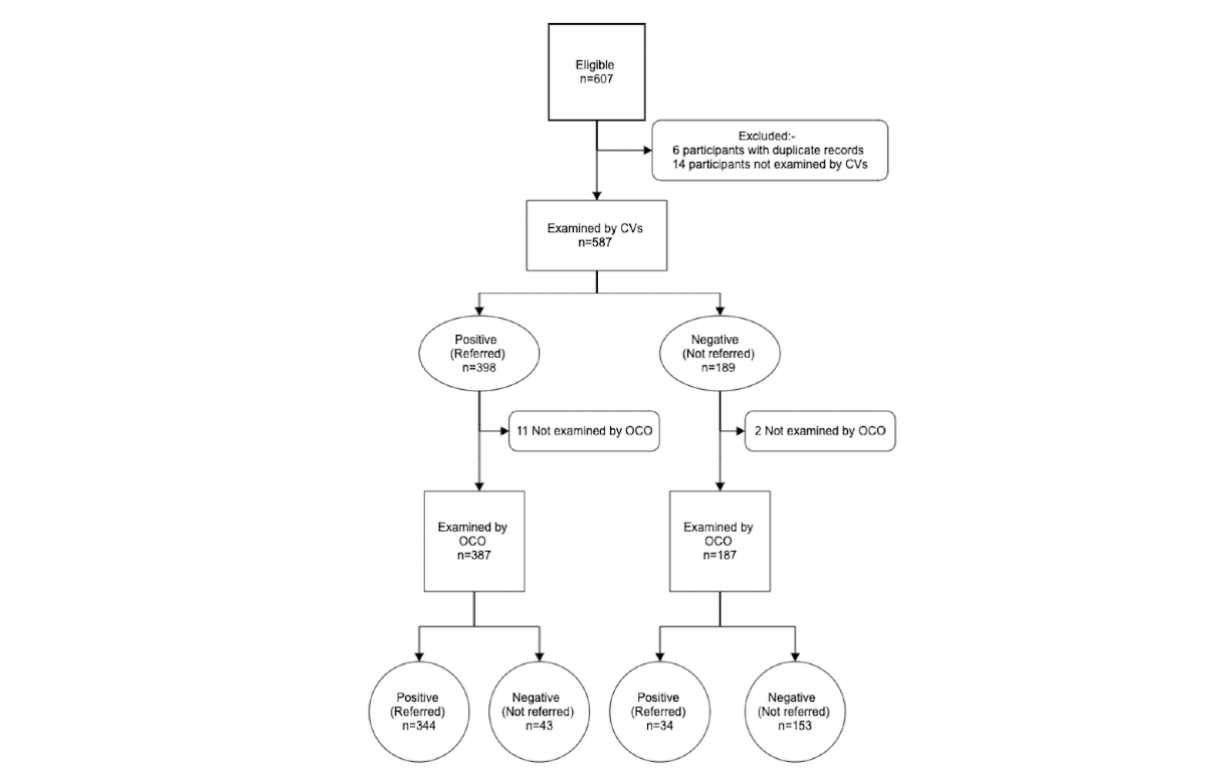
Figure 3. A Standards for the Reporting of Diagnostic Accuracy Studies flow chart for study participants. CVs: community volunteers; OCO: ophthalmic clinical officer.